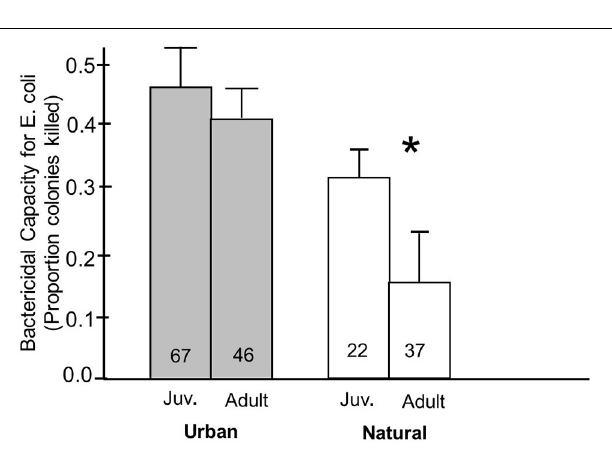
FIGURE 4 | Bactericidal capacity against E. coli in plasma from juvenile and adult birds breeding in urban and natural habitats. A Fisher’s PLSD post hoc analysis was used to determine whether breeding in an urban or natural site influenced the differences in bactericidal capacity in juvenile and adult birds. In natural environments, juvenile birds had significantly higher bactericidal capacity against E. coli than natural birds. This relationship was not present in urban environments. Numbers in the bars indicate sample sizes and an asterisk above indicates a significant difference between juvenile and adult